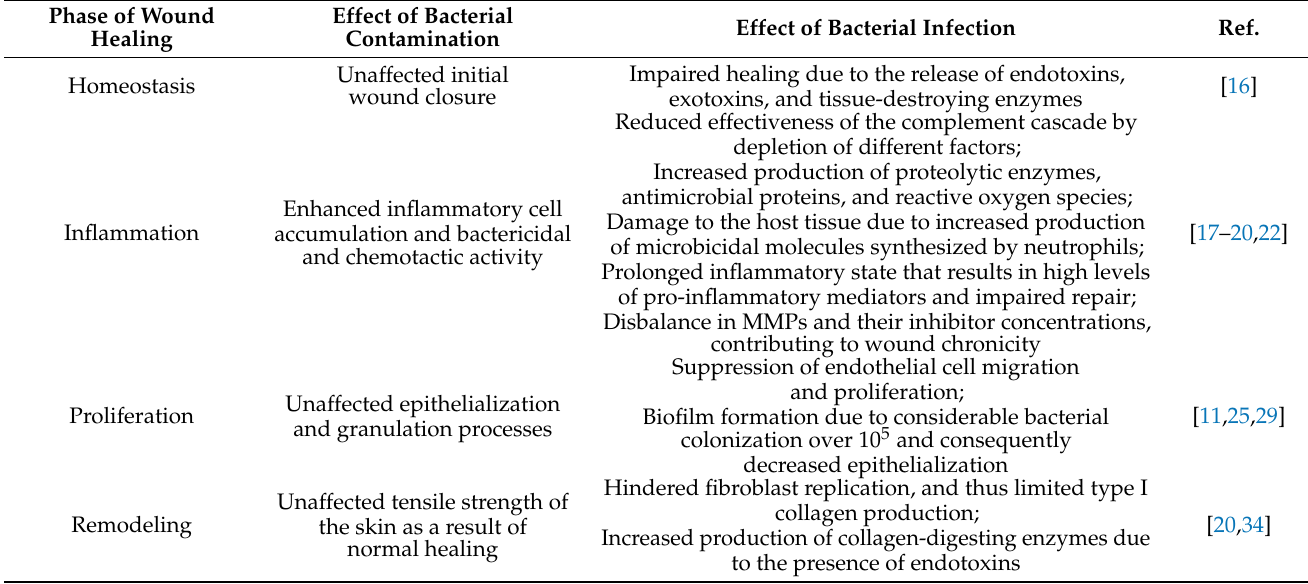
Table 1. Comparison of the effects of bacterial contamination and bacterial infection on wound